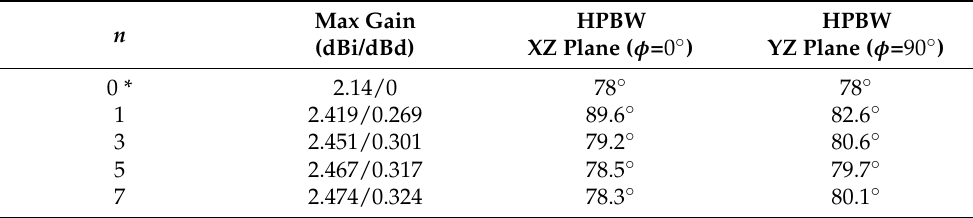
Table 1. The Maximum Gain and HPBW of the straight half-wave dipole and 50 Ω sinusoidal dipoles for different n